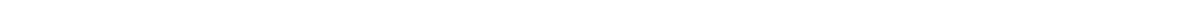
Fig. 9 Loss of endothelial Notch1 augments atherosclerotic plaque burden in a model of hypercholesterolemia. a Timeline for mouse model of hypercholesterolemia. b Quanti fi cation of liver LDLR protein levels by immunoblot to con fi rm PCSK9 activity in PCSK9-AAV-injected animals compared to control-AAV-injected animals at time of harvest (PDI used as loading control). Each lane corresponds to one animal. c Circulating cholesterol levels at time of evaluation (12 weeks after AAV injection) ( n = 6 – 11 per group, each dot corresponding to one animal). Indicated are individual cholesterol levels in each group. d Representative aortas from each of the four groups: Control +AAV CT, Notch1 ECKO + AAV CT, Control + PCSK9, and Notch1 ECKO + PCSK9. Control animals were Cre + tdTomato reporter. e Example of aorta stained with Sudan IV for quanti fi cation of atherosclerotic plaque area and identi fi cation of the arch and descending aorta regions. f Quanti fi cation of plaque burden in the whole aorta, arch, and descending aorta was determined by calculating the percent of aortic surface area covered by atherosclerotic lesions in each group ( n = 6 for Control and n = 9 for Notch1 ECKO ). Each point represents the lesion area per mouse. The mean area for each group of mice is indicated by the horizontal bars. T- test * P < 0.05, ** P < 0.01, ns = not signi fi cant. g En face imaging of wild-type (C57BL/6) adult mouse aorta reveals enhanced nuclear presence of Notch1 (red) in endothelial cells of the descending aorta compared to endothelial cells of the lower arch (representative images of n = 6). Scale bar = 20 µ m. h Venus Notch reporter mouse aorta imaged en face to assess Notch signaling comparing the descending aorta to the arch (representative images of n = 3). Scale bar = 20 µ m. i Protein lysates from bovine aorta (descending aorta, lower arch and smooth muscle) were analyzed by immunoblot for expression of Notch1 intracellular domain (NICD) and Klf2 using Ve-Cadherin as loading control. Each lane shows isolation from a distinct biological replicate. NICD levels trend with Klf2 expression level differences between the descending aorta and lower arch (data from nine technical replicates isolated from four biological replicates are shown on graph, T- test **** P <